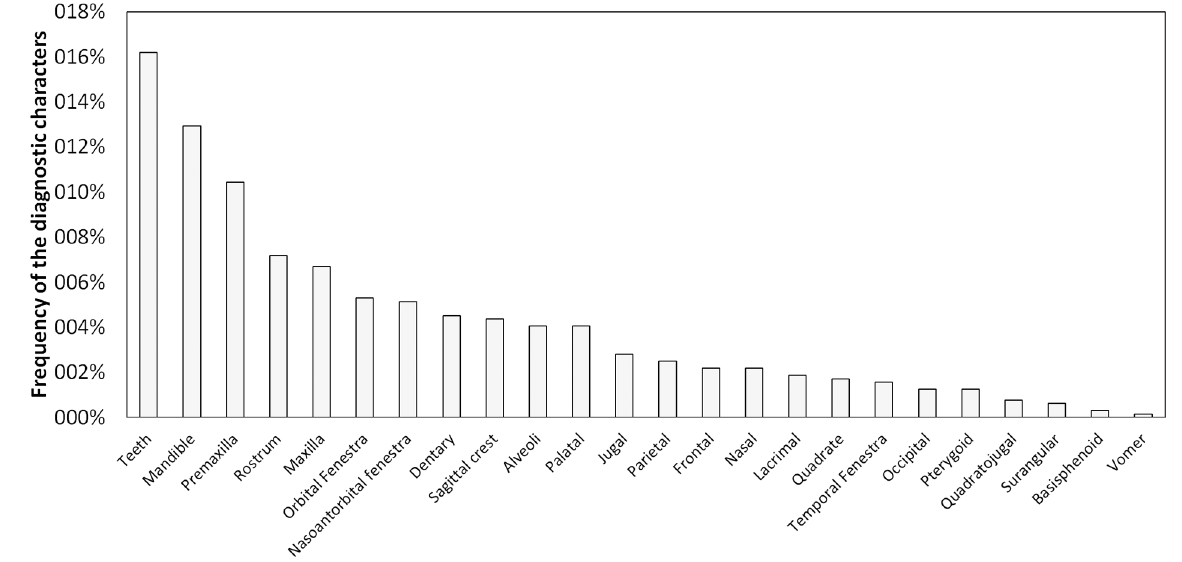
Figure 2. Frequency of cranial elements diagnosing new pterosaur